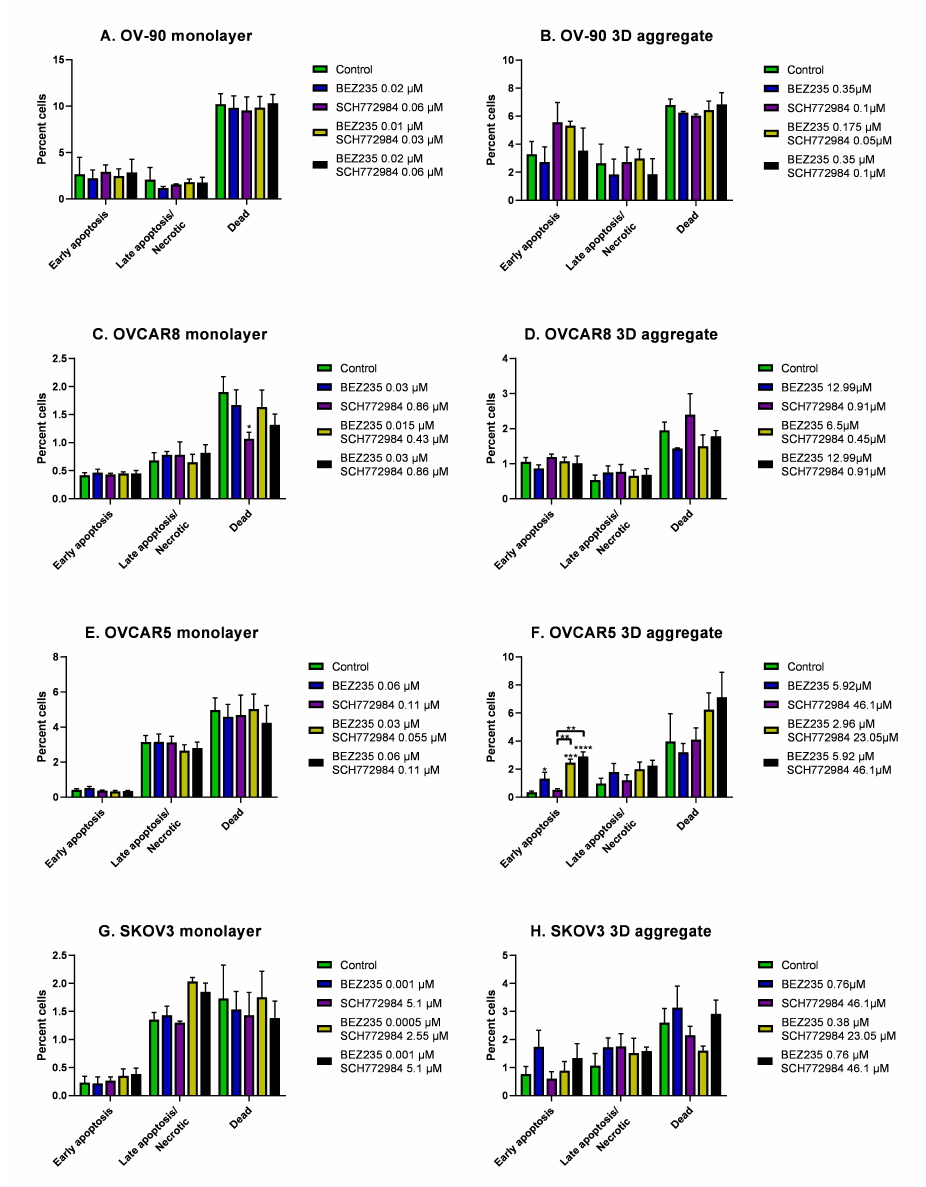
Figure 4. The percentage of cells in early apoptosis (Annexin+/propidium iodide (PI)-) or late apoptosis/necrotic (Annexin+/PI+) and the percentage of dead cells (Annexin-/PI+) after 24 h exposure to BEZ235 and SCH772984, alone and in combination. No significant changes were seen in the percent of early apoptosis or late apoptosis/necrotic cells and dead cells after 24 h exposure to BEZ235 and SCH772984, alone and in combination, in OV-90 monolayers or aggregates ( A , B ), OVCAR8 monolayers or aggregates ( C , D ), OVCAR5 monolayers ( E ) and SKOV3 monolayers or aggregates ( G , H ). The percentage of OVCAR5 aggregate cells in early apoptosis (Annexin+/PI-) increased in response to BEZ235 alone and in combination with SCH772984 ( F ). Data are expressed as mean ± SEM (n = 3). Statistical significance is at p < 0.05 and is in comparison to the control. The statistically significant differences are indicated as p < 0.05(*), p < 0.01 (**), p < 0.001 (***) and p < 0.0001 (****), as determined by two-way ANOVA with Tukey’s multiple comparison test on log transformed data. Any statistically significant differences between treatment groups is indicated by horizontal significance